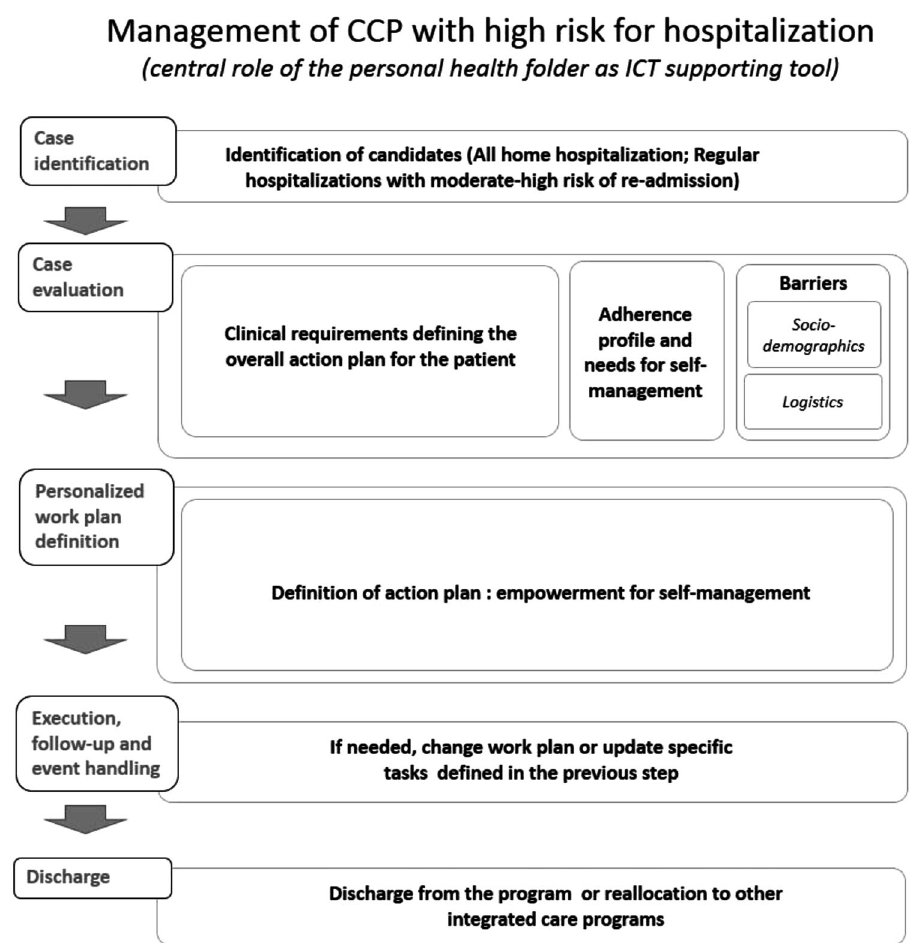
Fig. 3 General service work fl ow. General description of the service work fl ow through six sequential steps